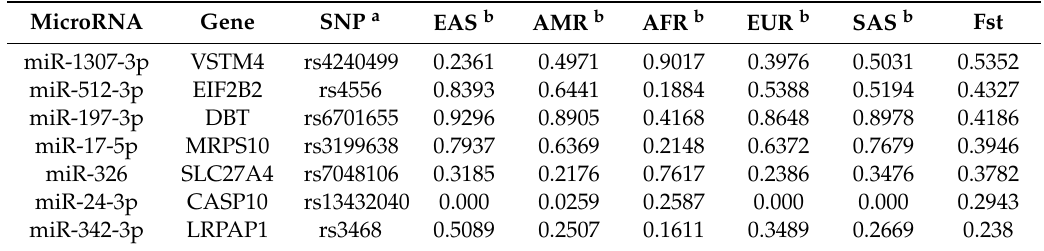
Table 2. Target sites identified in high-throughput experiments with high population di ff erentiation.